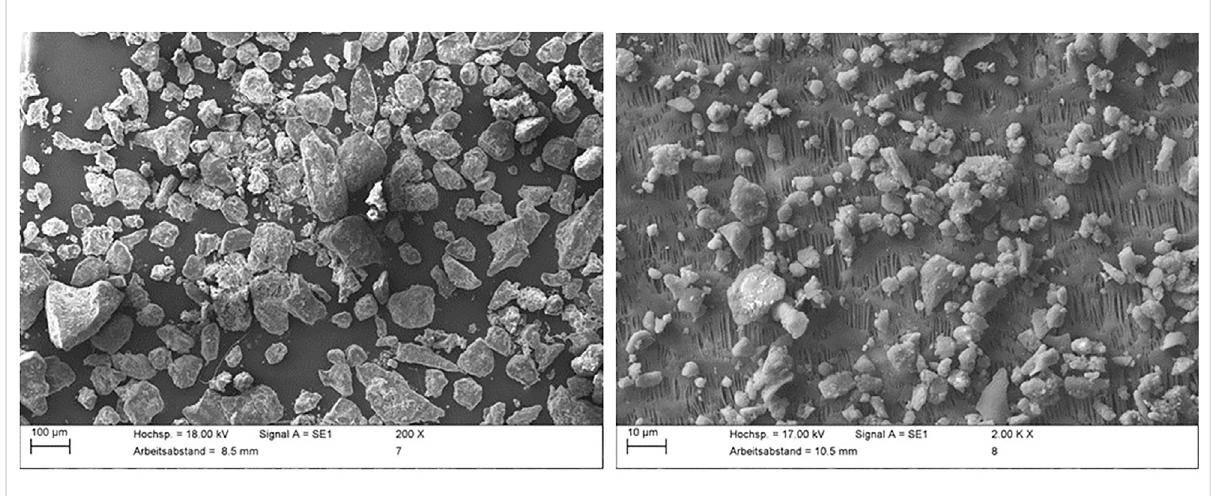
FIGURE 2 Overviewofparticlessampledon fi ltersoftheEDMin1 mheight(left,onanadhesivestub)and4 mheight(right,onacut-outofthe fi lter),scale bars in the lower left